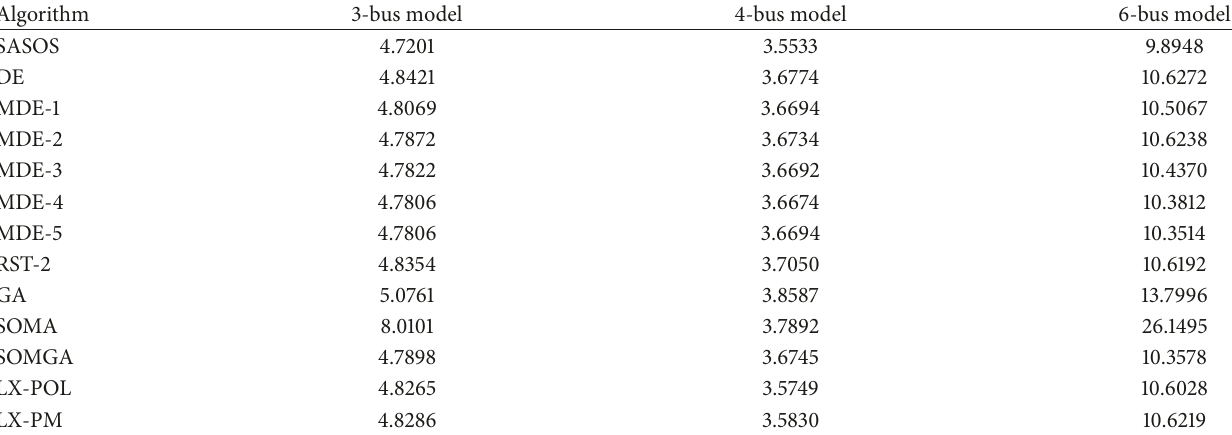
Table 4: Comparison of results obtained by SASOS and other algorithms for IEEE 3-, 4-, and 6-bus systems.